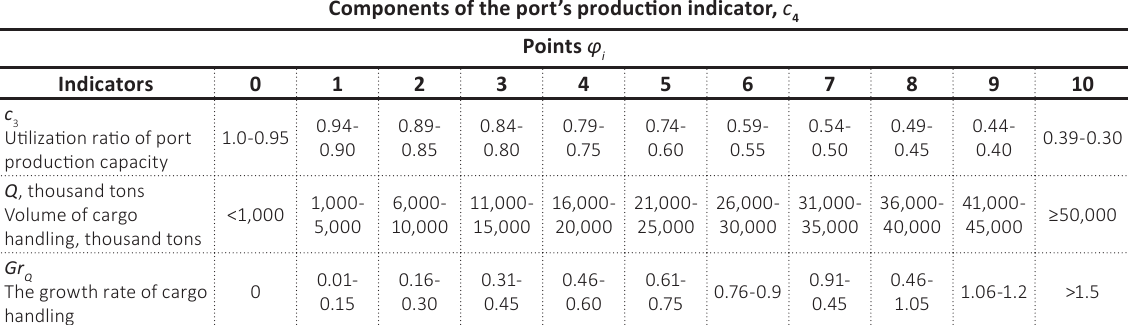
Source: Developed by the